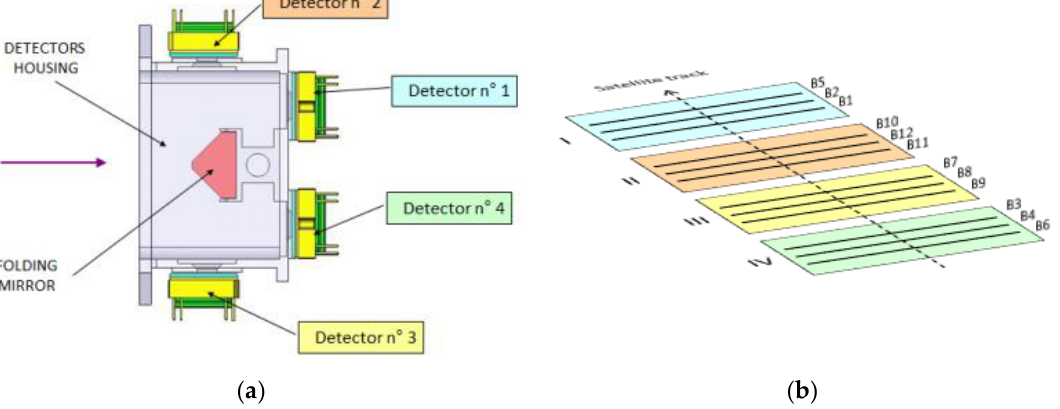
Figure 2. VEN µ S spectral bands. Figure 2. VEN μ S spectral bands. Figure 2. VEN μ S spectral bands.